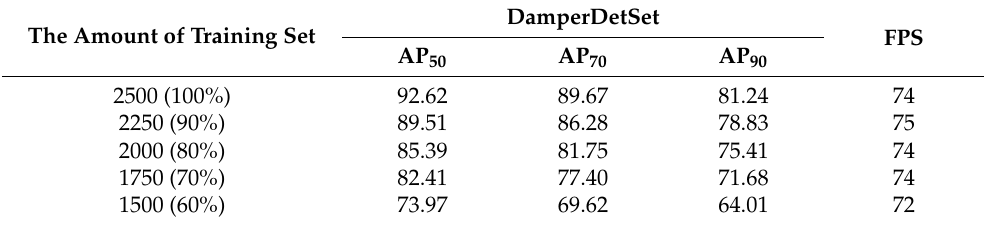
Table 7. Results of minimum training data experimental.